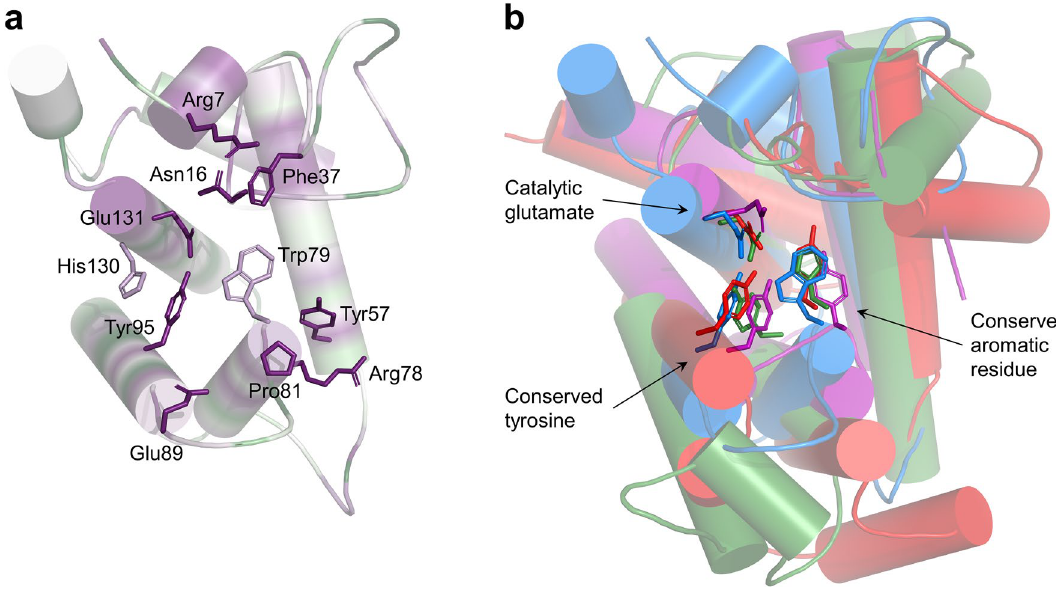
Figure 4. Substrate binding groove of the Enc34 endolysin and its structural homologs. ( a ) Conserved residues within the large groove of the Enc34 endolysin. The protein is colored as in Fig. 3. ( b ) 3D alignment of the Enc34 endolysin (blue), Thermotoga maritima TM0633 (magenta), phiKZ gp144 (green) and Escherichia coli MltC (red) proteins. The superimposition was performed by pairwise comparing the Enc34 EAD with the structural homologs using DALI 25 . Additional domains of the gp144 and MltC proteins have been removed for